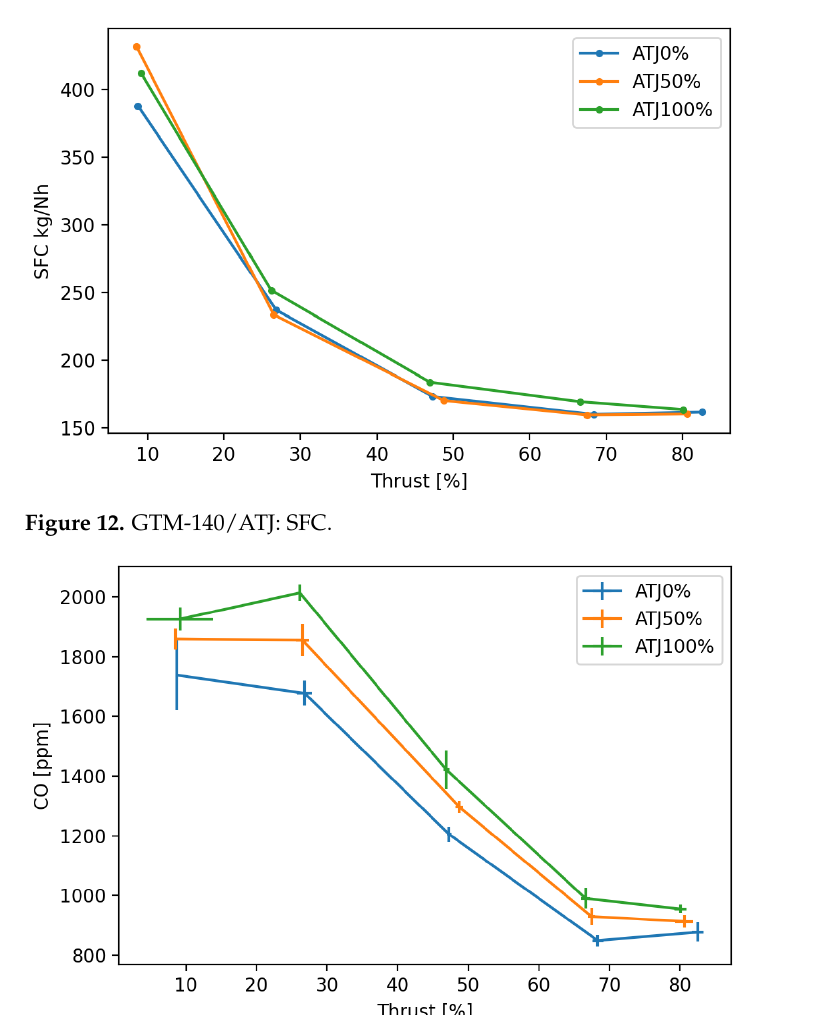
Figure 11. GTM-140/ATJ: Thrust.